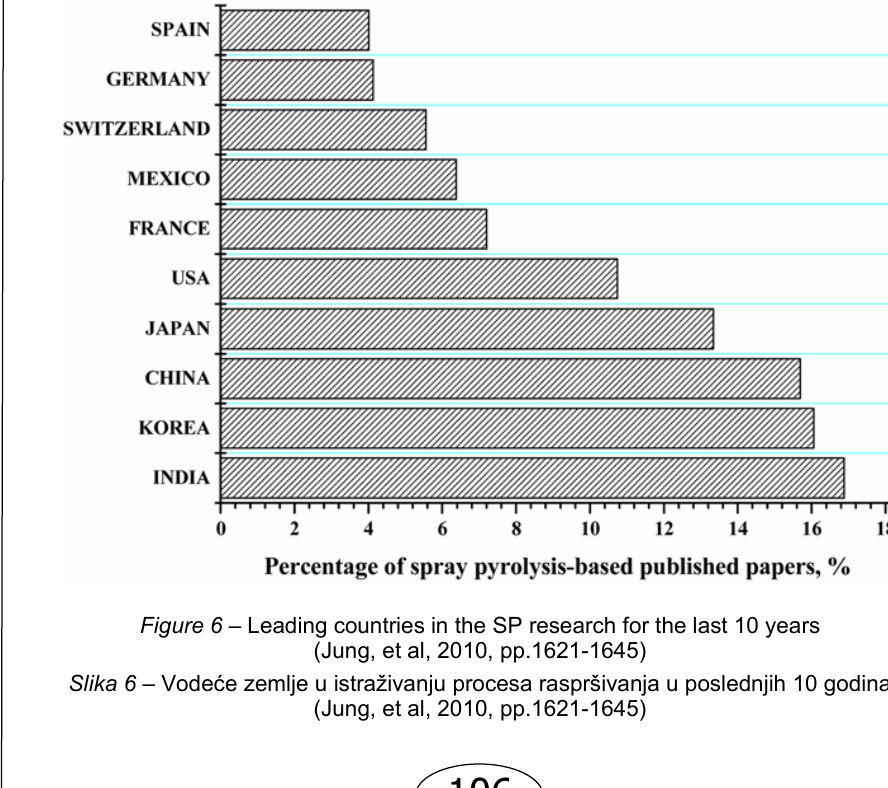
Figure 6 – Leading countries in the SP research for the last 10 years (Jung, et al, 2010,